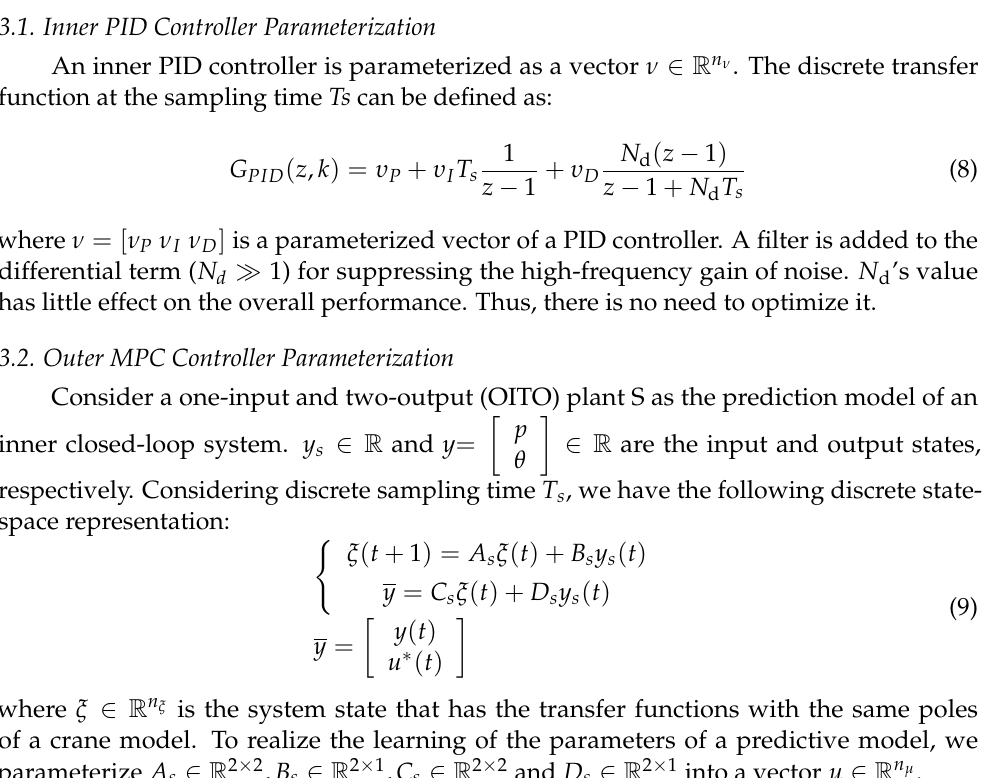
Figure 2. Proposed dual-layer control architecture.